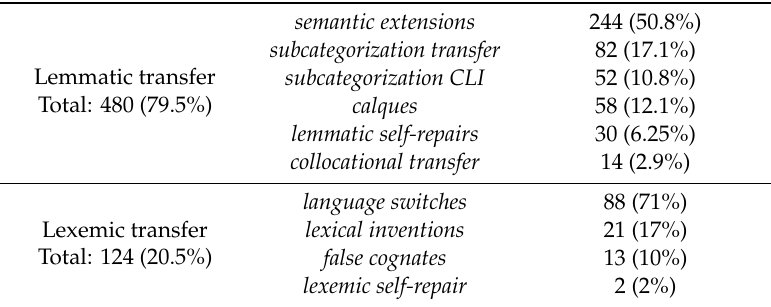
Table 3. Tokens and percentages of lemmatic and lexemic